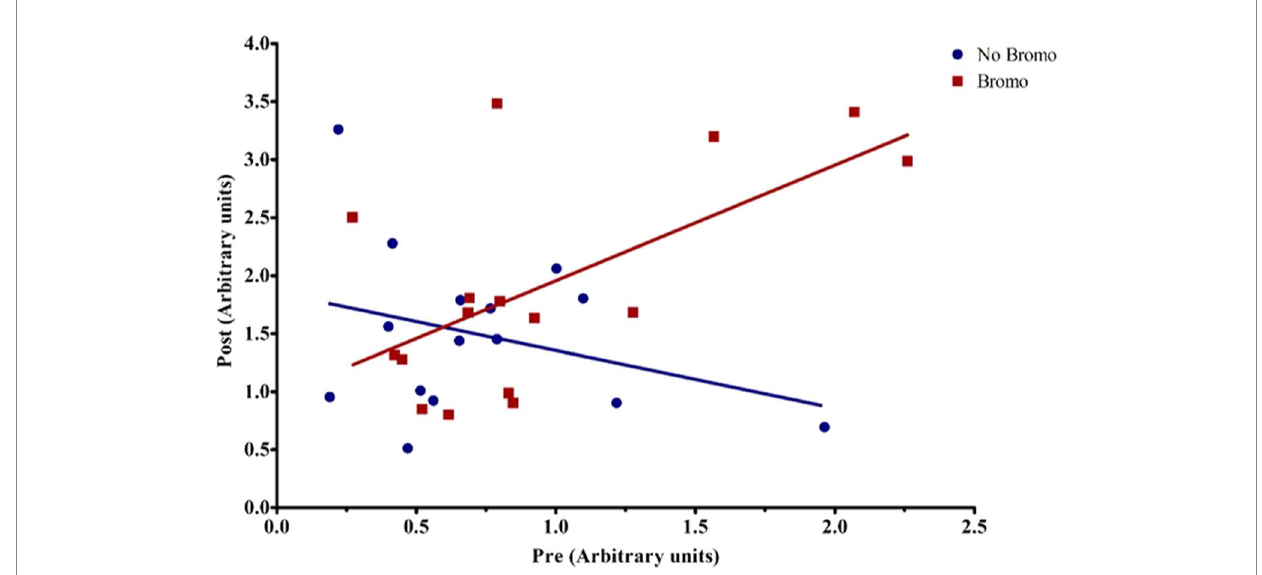
FIGURE 4 Representative graph of the interaction between pre-infusion levels of phosphorylated mTOR and bromocriptine treatment on post-infusion levels of phosphorylated mTOR. For covariate analysis, pre and its treatment interactions were first tested as fixed effects (pre, pre x bromo, pre x implant, and pre x bromo x implant) to determine which covariates were significant ( p < 0.05). Insignificant covariates were dropped from the model. The pre x bromo interaction was significant ( p = 0.0012), demonstrating that pre glucose infusion levels of phosphorylated mTOR affected the amount of phosphorylated mTOR found post infusion in animals treated with bromocriptine. There was a positive relationship between pre- and post- infusion abundance in bromocriptine treated steers (red fitted line). In the absence of bromocriptine (blue fitted line), there was no relationship between pre- and post-infusion phosphorylated protein abundance. Each point represents an individual